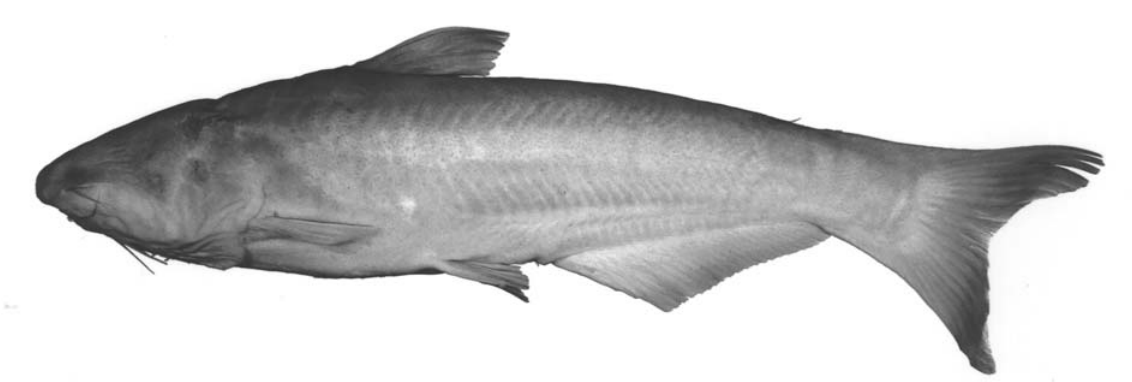
Fig. 56. Paracetopsis bleekeri , ZMH 12211, 158 mm SL; Ecuador, Guayas, Guayaquil (2°10’S,